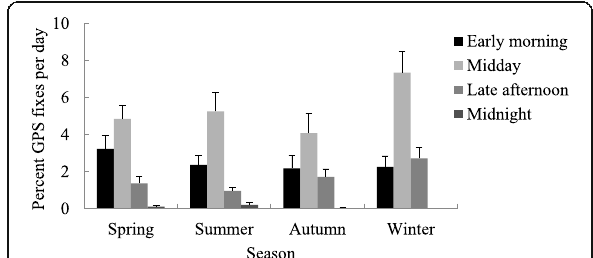
Fig. 8 Percentage and standard error of the number of GPS fixes 30 m around water locations per day of a free-ranging cattle herd ( N = 11) during four 3-h time periods for eight trials of 3 weeks from September 2007 to August 2008 in a semi-arid rangeland in South